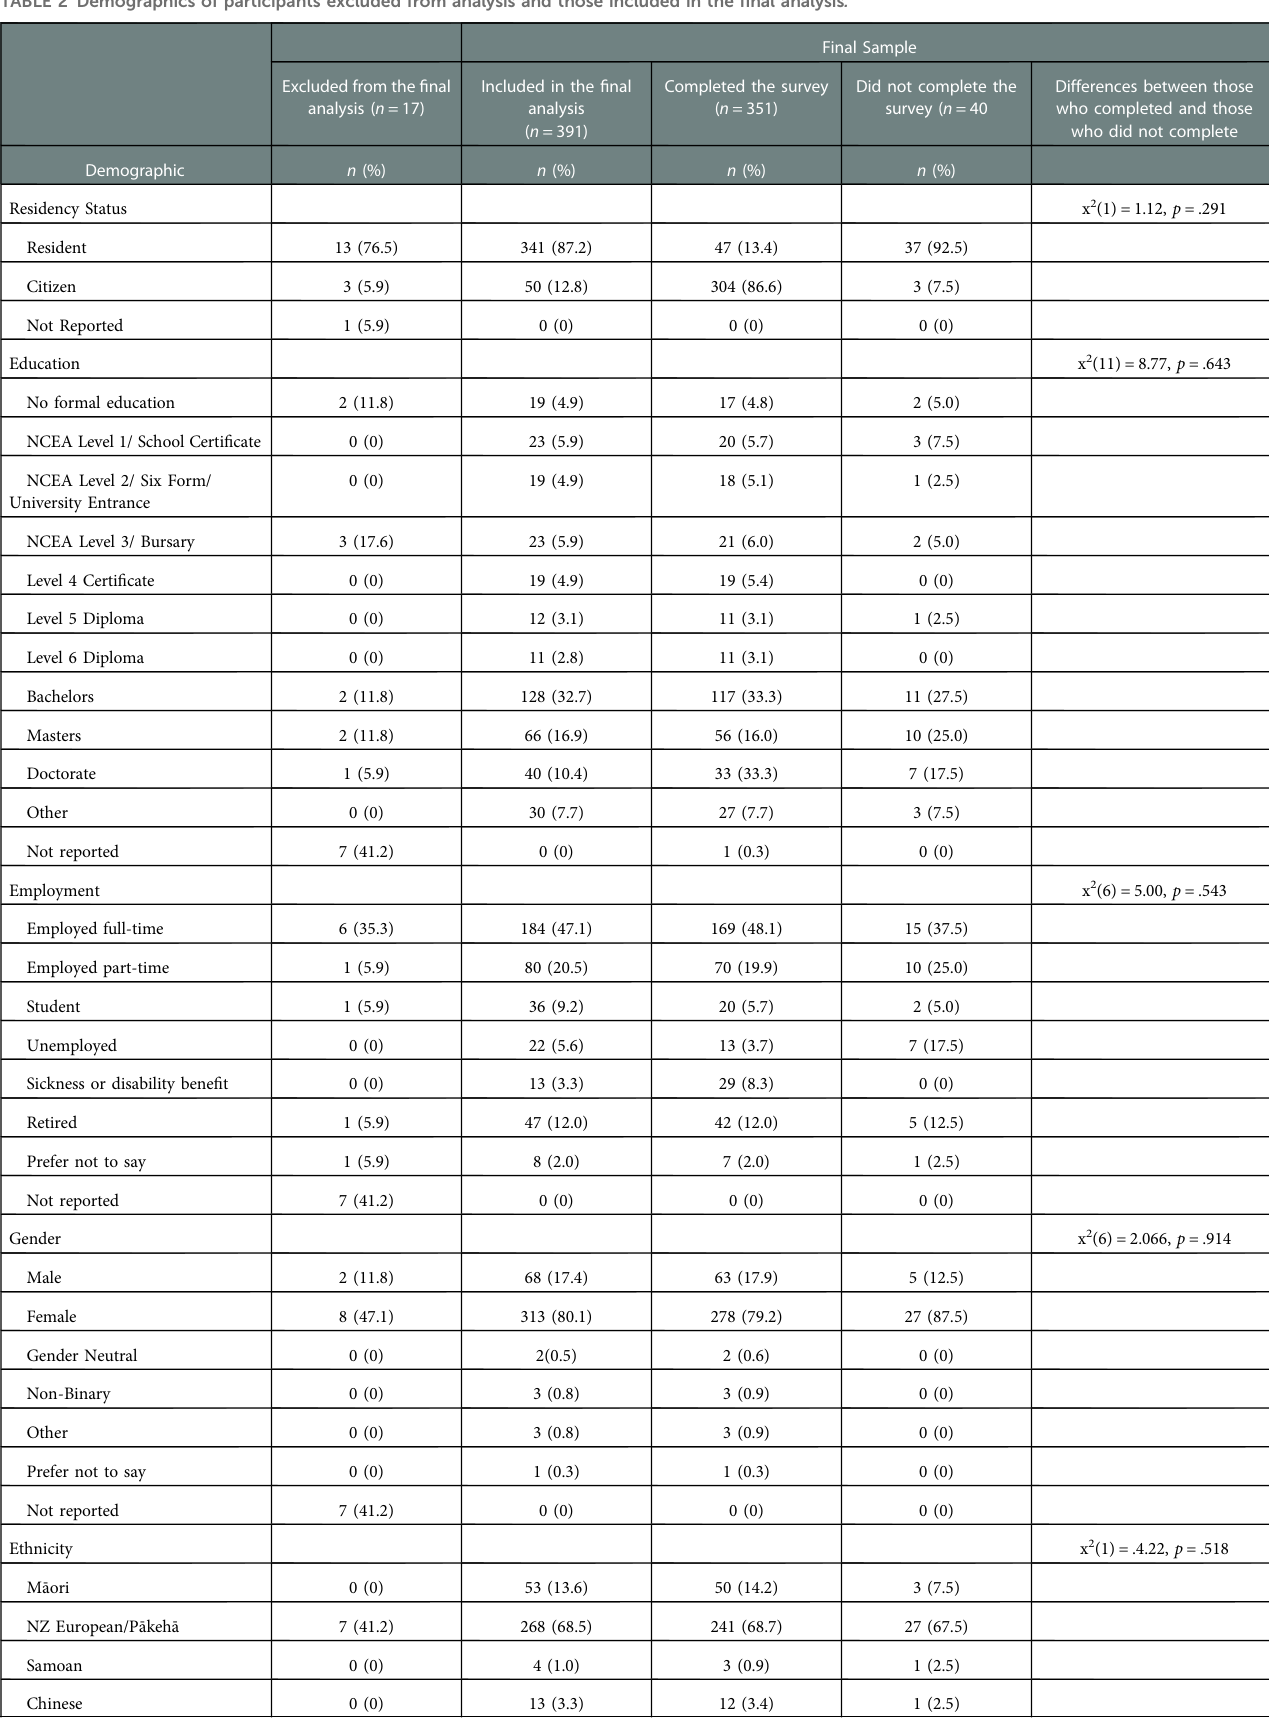
TABLE 2 Demographics of participants excluded from analysis and those included in the fi nal analysis